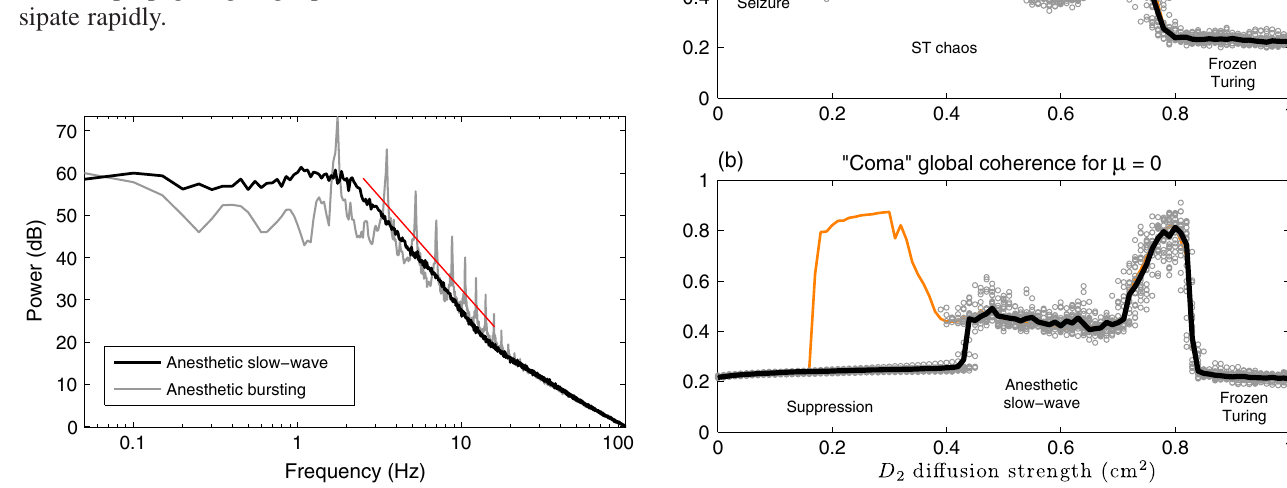
~ Q f Þj 2 power spectra for anes- FIG. 11. Spatially averaged j FIG. 12. Phase coherence trends for (a) wake ( (cid:13) i ¼ 1 : 00 ) and e ð thetic slow-wave (thick-black curve: D 2 ¼ 0 : 4 cm 2 ) and bursting (b) coma ( (cid:13) i ¼ 1 : 018 ) for a homogeneous cortex devoid of (gray curve: D 2 ¼ 0 : 3 cm 2 ) time series illustrated in Figs. 10(a) two-point connections (i.e., (cid:12) ¼ 0 ). Bold-black curves show and 10(b), respectively. Power is expressed in dB relative to the the median trend through data points (gray circles) obtained value at 100 Hz. Bursting, but not slow-wave, shows pronounced from 2020 homogeneous cortex experiments; these (cid:12) ¼ 0 bold- resonances at f 1 ¼ 1 : 75 Hz and its harmonics nf 1 , n ¼ 2... 12 . black trends are superimposed on the (cid:12) ¼ 200 thin-orange The red line shows the best-fit trend for the power law P (cid:7) f (cid:2) 4 : 4 . median fits from Figs. 7(a) and 7(b) to illustrate the impact of Frequency resolution for both spectra is 0.05 Hz. suppressing the two-point axonal connection.